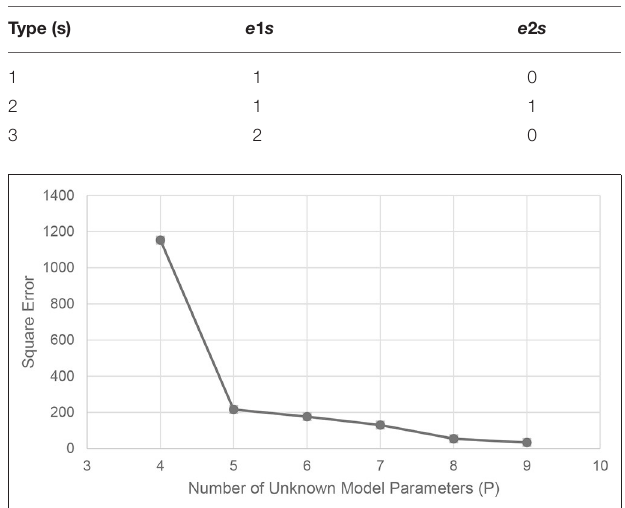
TABLE 1 | Type of flows considered in the compartmental model.